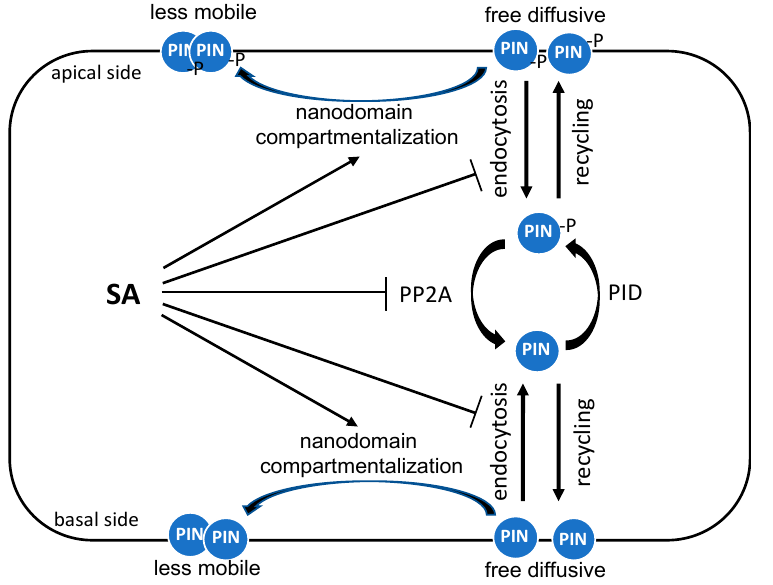
Figure 3. Regulation of the auxin polar distribution by SA. The auxin polar distribution, which is important for auxin-mediated growth and development, is largely mediated by the polar distribution of PIN auxin efflux transporter proteins through regulated endocytic recycling. SA disrupts endocytic recycling of PIN proteins by inhibiting their endocytosis, affecting their phosphorylation through inhibition of PP2A and inducing their hyperclustering in the plasma membrane.